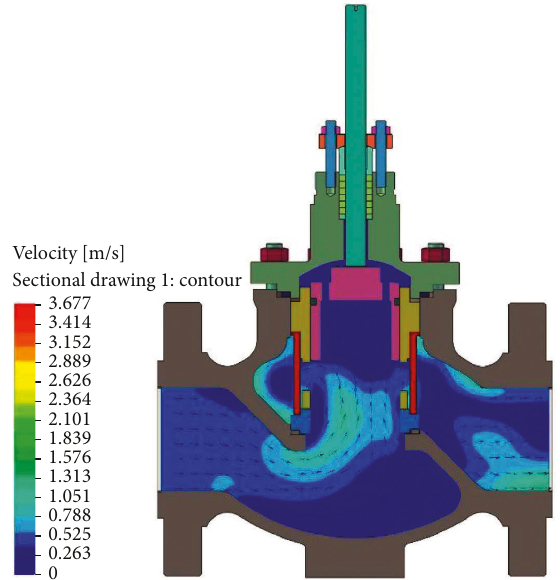
Figure 16: Vortex volume cloud map for 100%